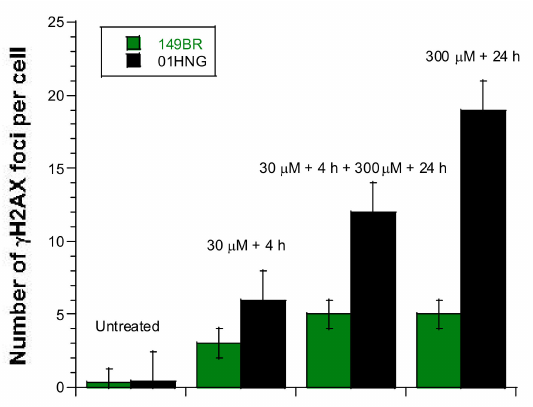
Figure 7. Evidence of an adaptive response-like phenomenon in cells exposed to metal. Number of γ H2AX foci per cell in the 01HNG (black) and 149BR (green) cells after incubation with the indicated concentrations of AlCl 3 . Each bar represents the mean ± standard error (SEM) of at least three